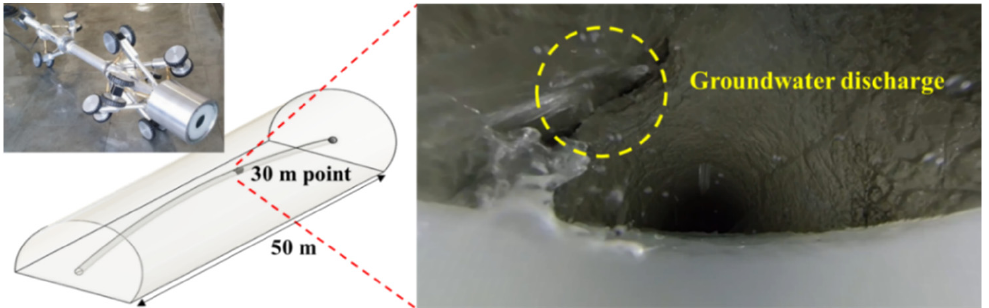
Figure 4. Prediction of rock mass conditions ahead of tunnel face through borehole alignment tracking and ground exploration system.